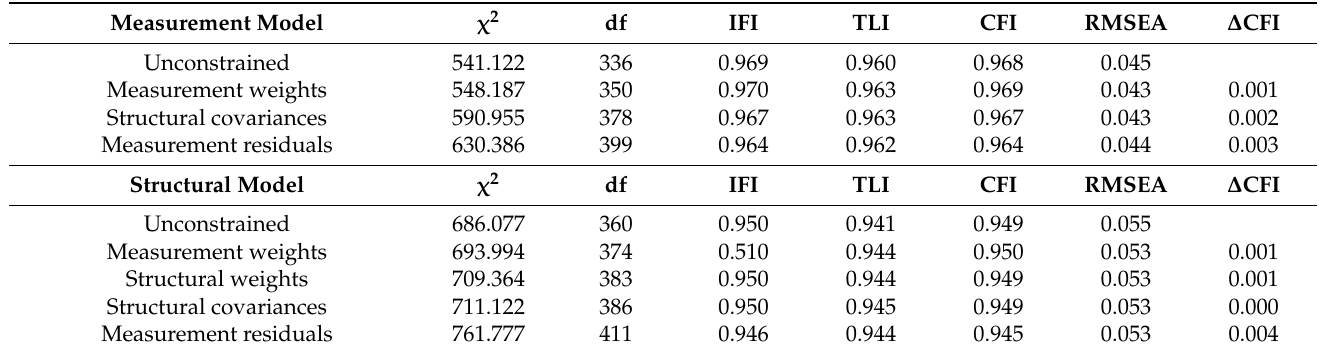
Table 5. Result of measurement invariance: Nested model comparisons.